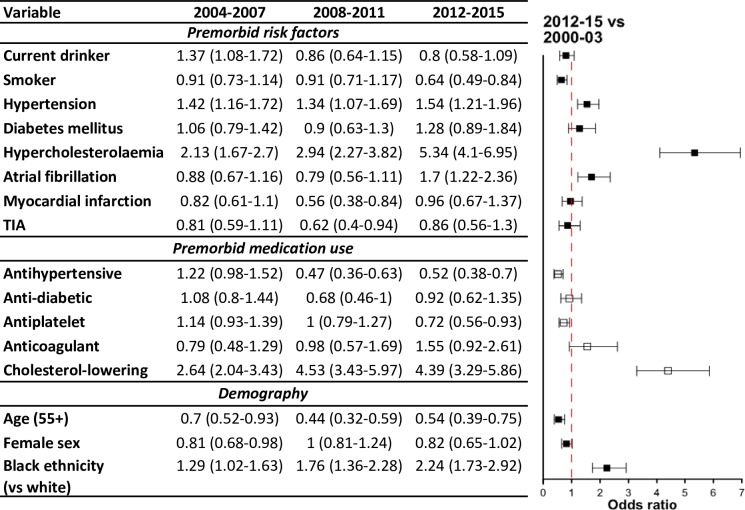
Multiply adjusted† changes in risk factor profile in first-ever IS patients (with reference to 2000–2003 index cases).Data are OR (95% CI). † for age, sex, ethnicity, and possible interaction between time and ethnicity as appropriate, after multiple imputation of missing values. IS, ischaemic stroke; OR, odds ratio; TIA, transient ischaemic attack.